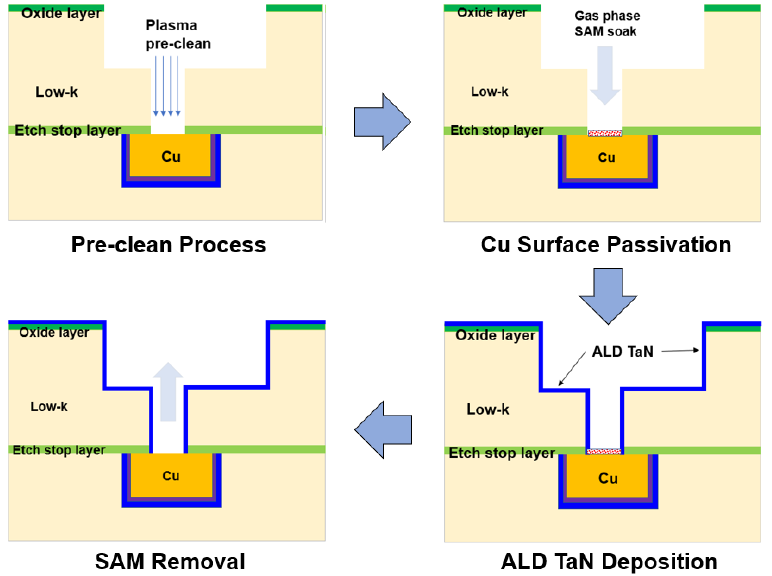
Figure 7. Selective barrier integration process. Reprinted/adapted with permission from Ref. [61]. 2021, IEEE.